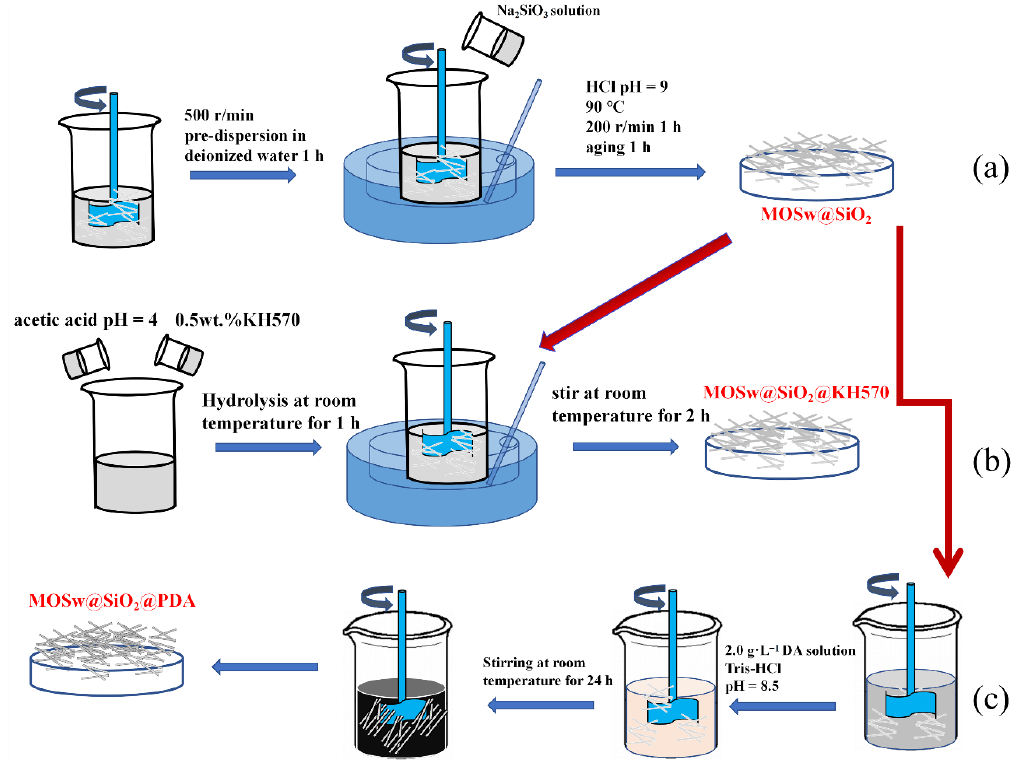
Figure 1. Preparation flowchart of ( a ) MOSw@SiO 2 ( b ) MOSw@SiO 2 @KH570 ( c ) MOSw@SiO 2 @PDA.